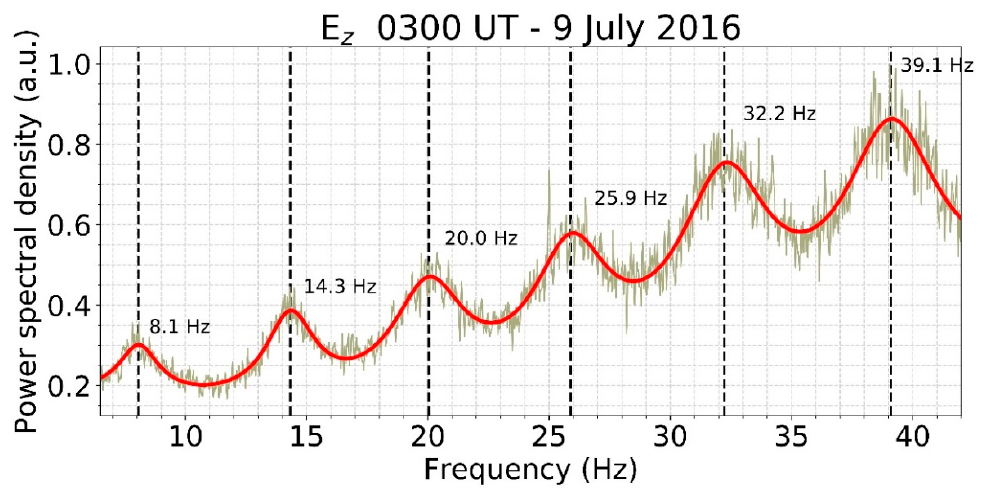
Figure 3. Typical raw spectrum of the output current, depending on the electric component of SR signal, measured at Portishead at 0300 UT on 9 July 2016, under favourable conditions. The spectrum is fitted with a sum of 6 Lorentzian functions (red line) and the peak frequency of each mode, determined by the best fit parameters, is shown. The rise of power with frequency is caused by the specific response function of the sensor.